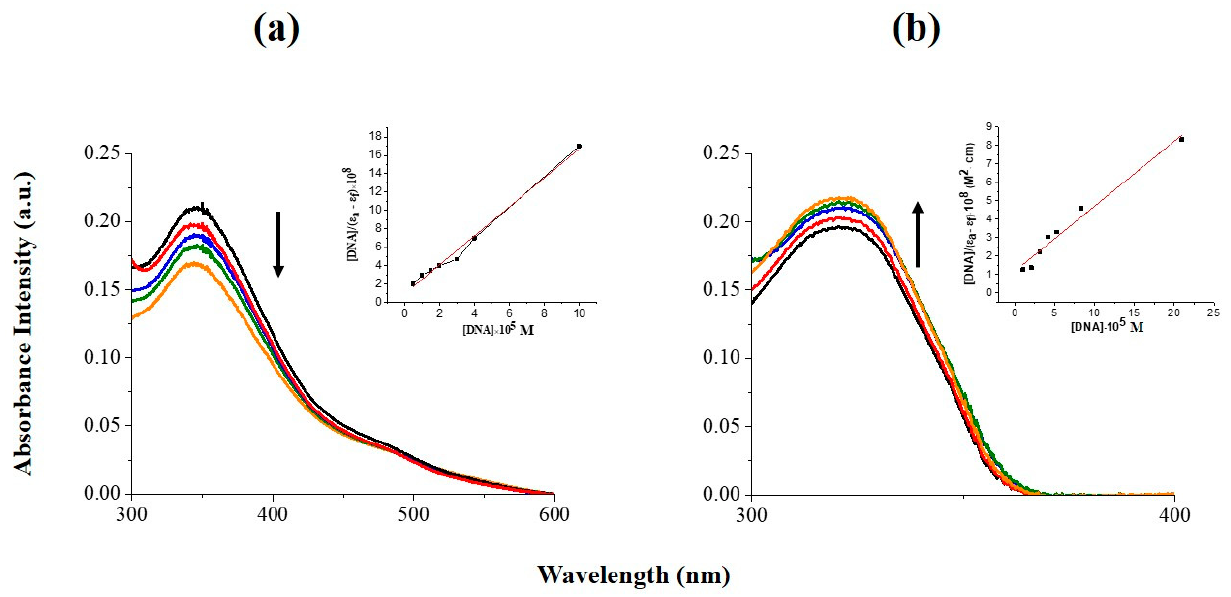
Figure 4. Absorption spectra of Cu-1 ( a ) and L1 ( b ) (10 − 5 M) in the absence and presence of increasing amounts of DNA (0–10 − 4 ) M. Indicative ratios R = [DNA]/[compound] are shown: R = 0 (black line), R = 0.01 (red line), R = 0.5 (blue line), R = 2 (green line), R = 10 (orange line). Inset: Plots of [DNA]/( ε a − ε f ) × 10 8 vs. [DNA] × 10 5 .